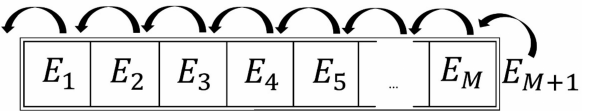
Figure 15. Averaging algorithms with window size M (Reprinted with permission from [18] © The Optical